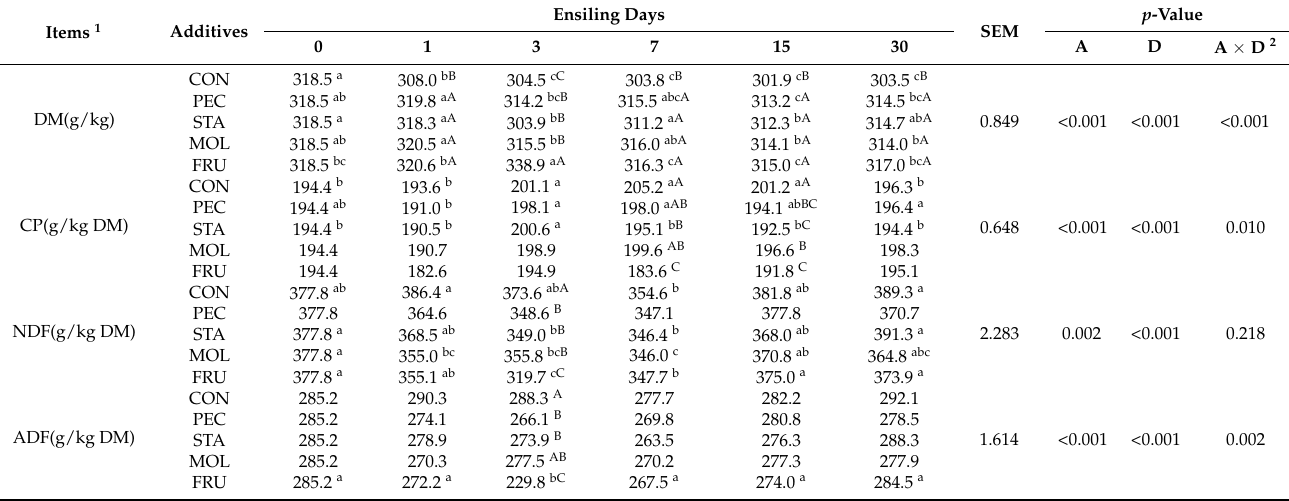
Table 3. The chemical composition of alfalfa before and after ensiling.